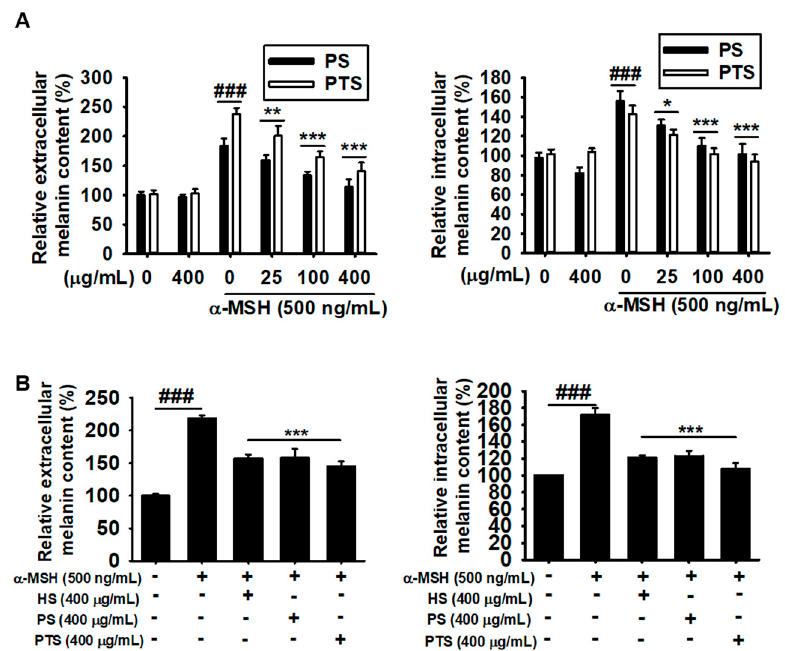
Figure 2. PS and PTS decrease extracellular and intracellular melanin production in α -MSH-stimulated B16F10 cells. ( A ) B16F10 cells were exposed to 500 ng / mL of α -MSH in the presence of 0-400 µ g / mL PS or PTS for 72 h, and extracellular (right) and intracellular (left) melanin contents were measured. ( B ) In a parallel experiment, the cells were treated with α -MSH (500 ng / mL), PS (400 µ g / mL), PTS (400 µ g / mL) or commercial H. sabdari ff a L. anthocyanin (HS, 400 µ g / mL) for 72 h, and extracellular (right) and intracellular (left) melanin contents were measured. The percentage values in each group are relative to those in the untreated control. Data are reported as the mean ± SEM of three independent experiments performed ( n = 3). ### p < 0.001 vs . untreated group; * p < 0.05, ** p < 0.01 and *** p < 0.001 vs . α -MSH-stimulated group.